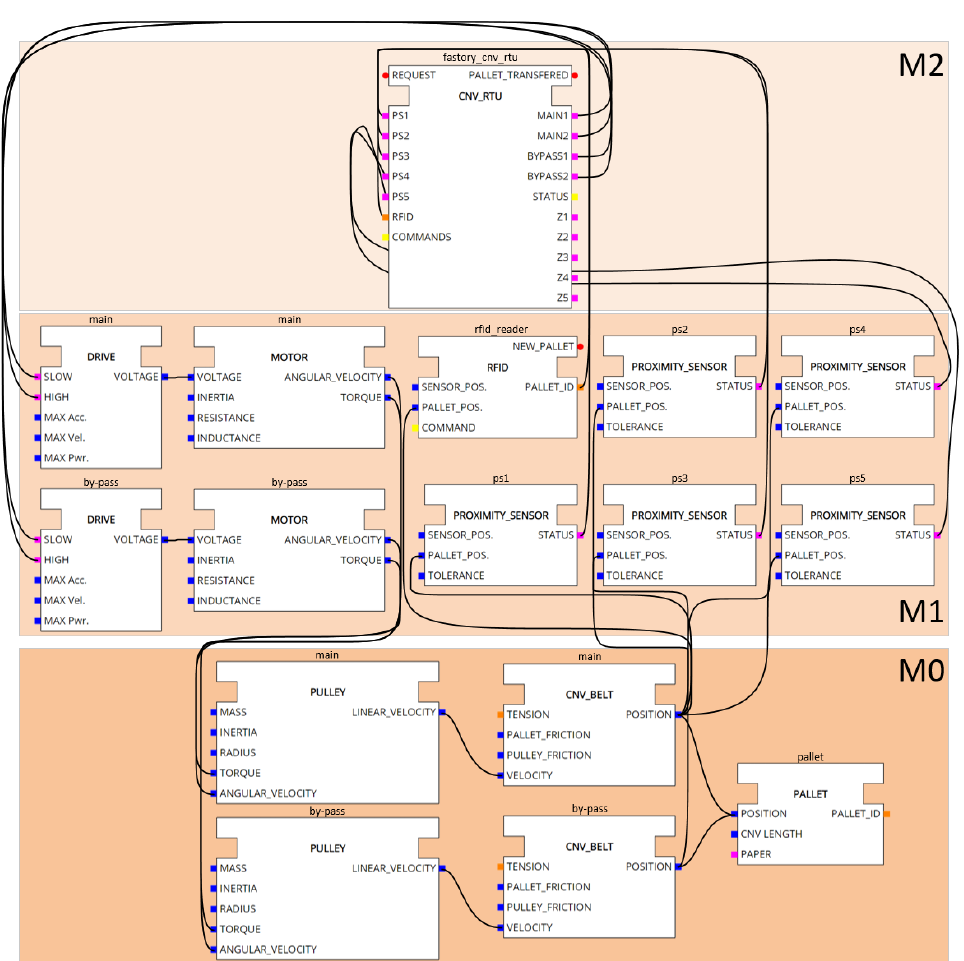
Figure 16. The composition of the transportation digital twin resource in the model layer. [Source: Own figure which is a snapshot from locally developed FB editor].